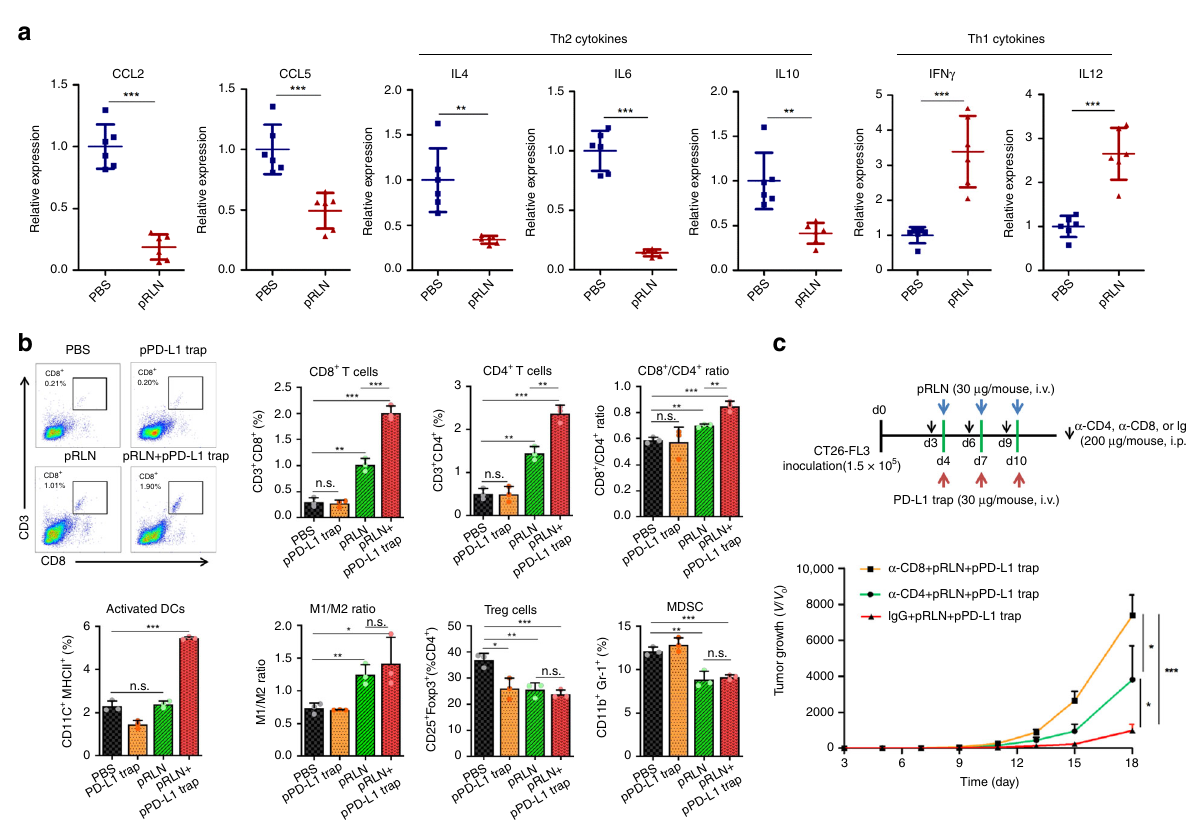
Fig. 5 pRLN therapy remodels immune microenvironment in the metastatic lesion. a Relative mRNA expression of chemokines and cytokines in the liver of male mice bearing CT26-FL3 liver metastasis receiving PBS or pRLN therapy on day 14 (4 days after the last injection) ( n = 6). b CD8 + T cells, CD4 + T cells, CD8 + /CD4 + ratio, activated DCs, M1/M2 ratio, Treg cells, and MDSC in the liver of male mice bearing CT26-FL3 liver metastasis receiving various treatments on day 14, analyzed by fl ow cytometry ( n = 3). c CD4 + or CD8 + T-cell depletion scheme for pRLN + pPD-L1 trap group and the metastatic growth curve ( n = 5). Signi fi cant differences were assessed in ( a , b ) using t test, in ( c ) using two-way ANOVA with multiple comparisons. Results are presented as mean (SD). * p < 0.05, ** p < 0.01, *** p < 0.001, n.s., not signi fi